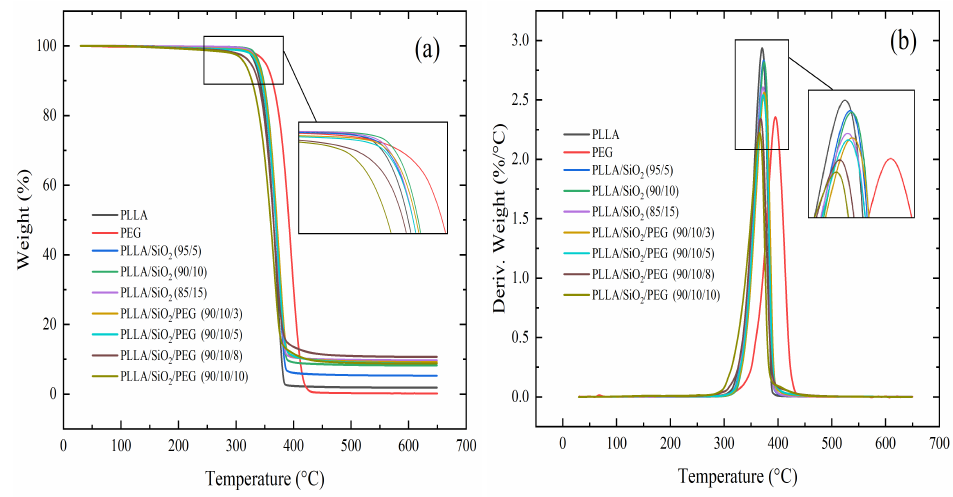
Figure 8. Thermogravimetric analysis of PLLA, PEG, PLLA/SiO 2 , and PLLA/SiO 2 /PEG: ( a ) weight curves (TGA) and ( b ) their derivatives (DTA). Table 8. TGA results of PLLA, PLLA/SiO 2 , and PLLA/SiO 2 /PEG (10 °C/min in N 2 ).